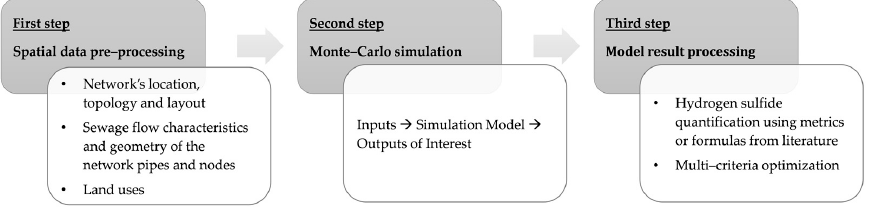
Figure 2. Steps of the optimal sewer mining unit placement methodology.